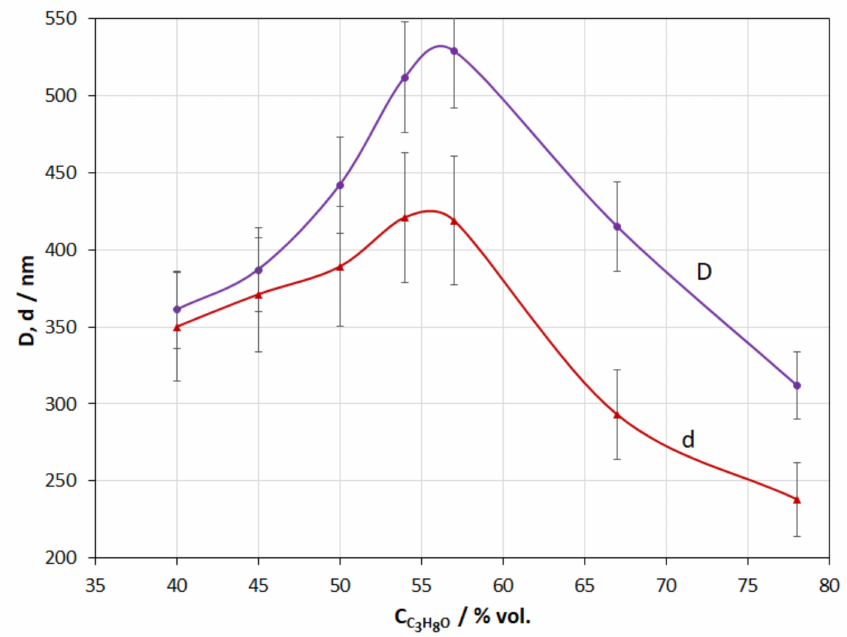
Figure 10. Dependence of the average coating thickness (D) and the average particle size (d) on the IPA amount in the reaction medium.